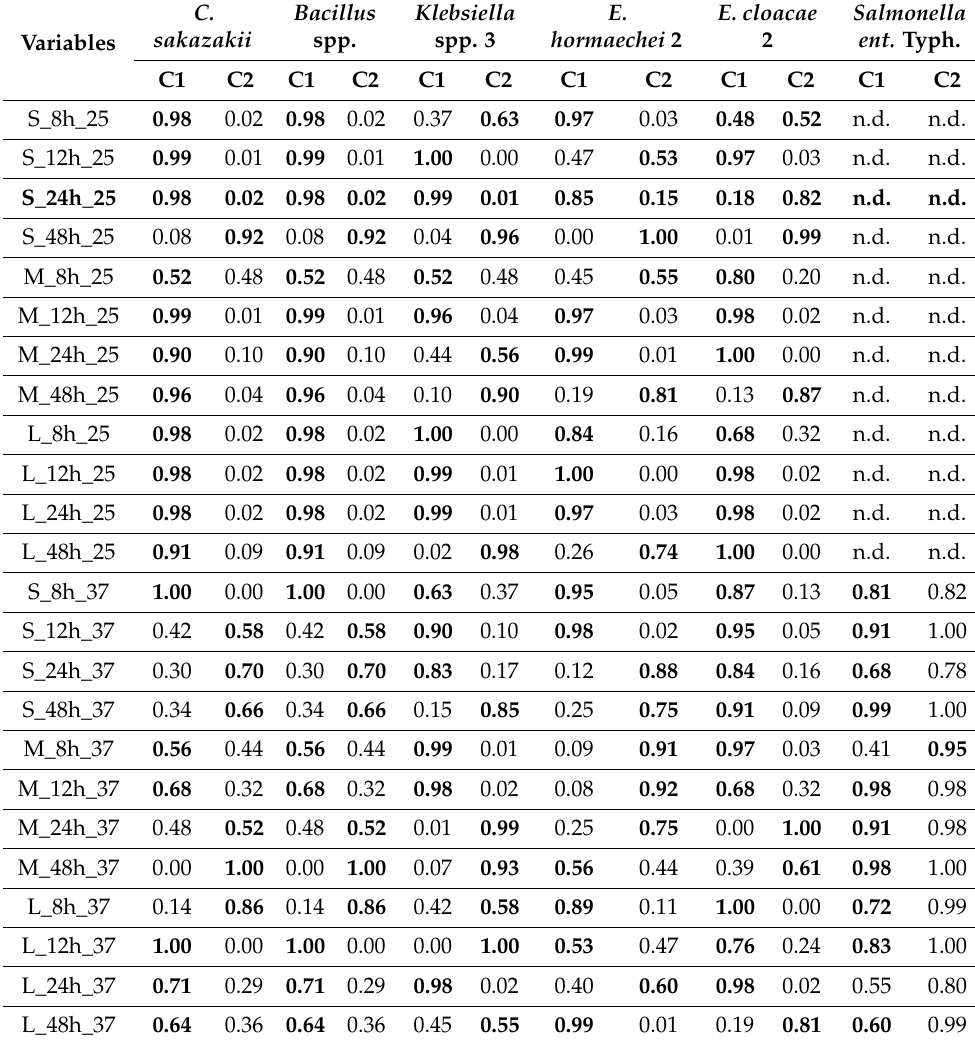
Table 4. Determination coefficient values of R 2 explaining the % variation in biofilm formation factors by principal